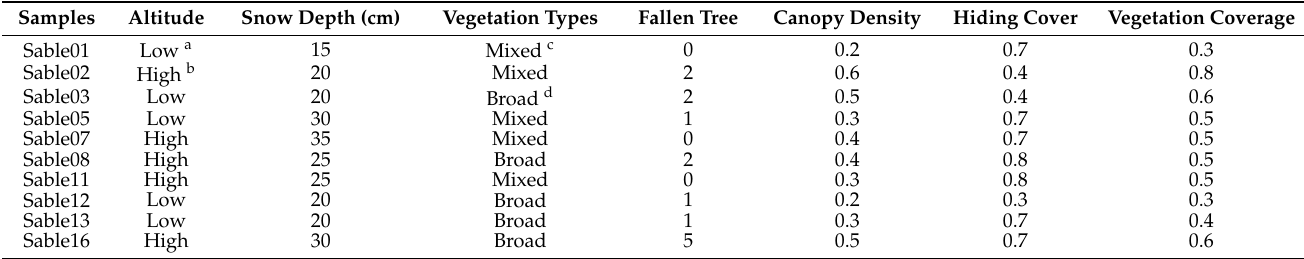
Table 1. Geographical information of sampling sites.